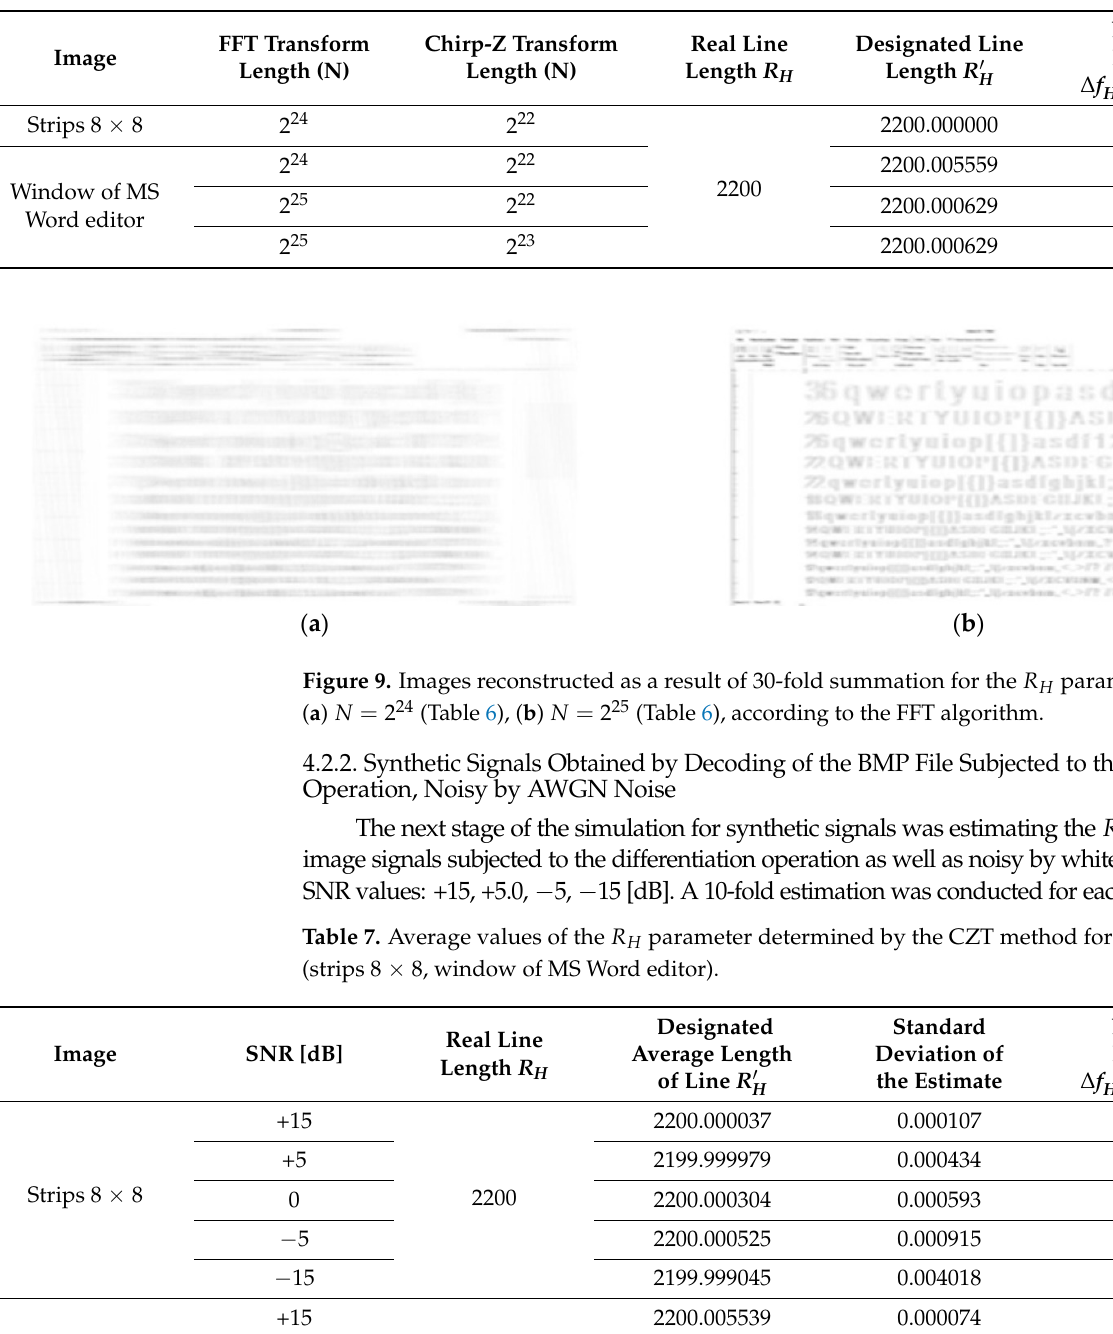
Table 6. The simulation results for the test signals (differentiated images).